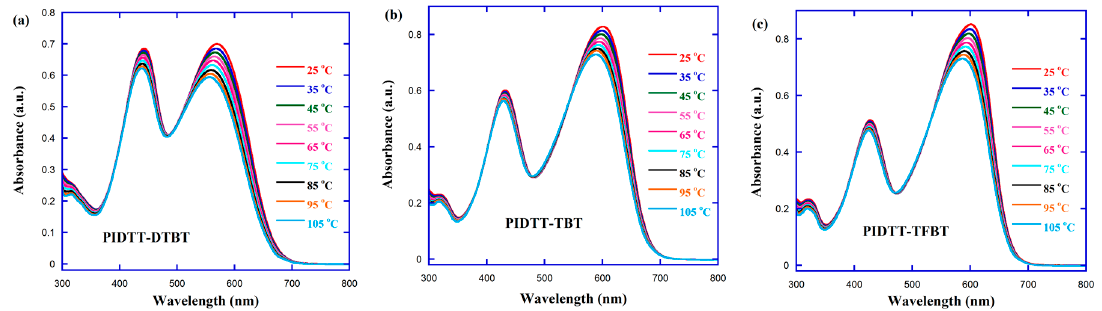
Figure 2. TD-Abs spectra for the studied copolymers PIDTT-DTBT ( a ), PIDTT-TBT ( b ), and PIDTT-TFBT ( c ) in CB.